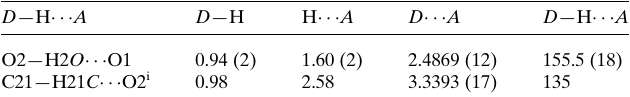
Table 1 Hydrogen-bond geometry (A˚ , (cid:2) ).